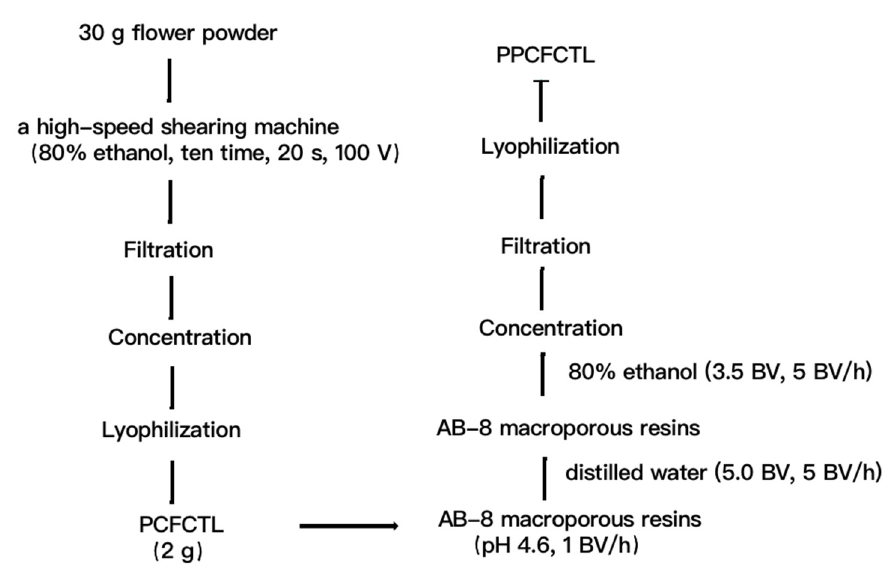
Figure 7. The schematic procedures for the extraction and separation of PCFCTL from Clitoria ternatea L. Total flavonoid content was measured using the reported method with minor modifica- tions [47]. According to the calibration curve of rutin, the flavonoid content was determined as mg RE/g mg (freeze-dried sample). RE stands for rutin